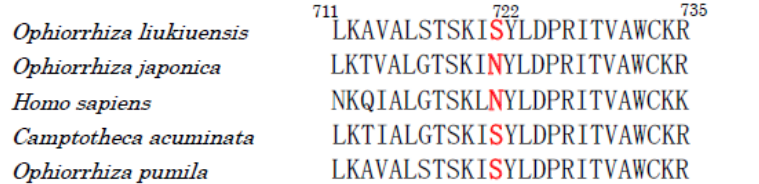
Figure 4. Comparison of the amino acid sequences of CPT is of the CPT-producing and CPT-nonproducing plants and humans. Ophiorrhiza liukiuensis , Camptotheca acuminate , and Ophiorrhiza pumila are CPT-producing plants, while Ophiorrhiza japonica and Homo sapiens are nonproducing. GenBank accession numbers are BAG31374, BAG31376, BAG31373, BAG31375, and AAA61206, respectively. The critical amino acid residues for the resistance (aspragine and serine) were marked with red.